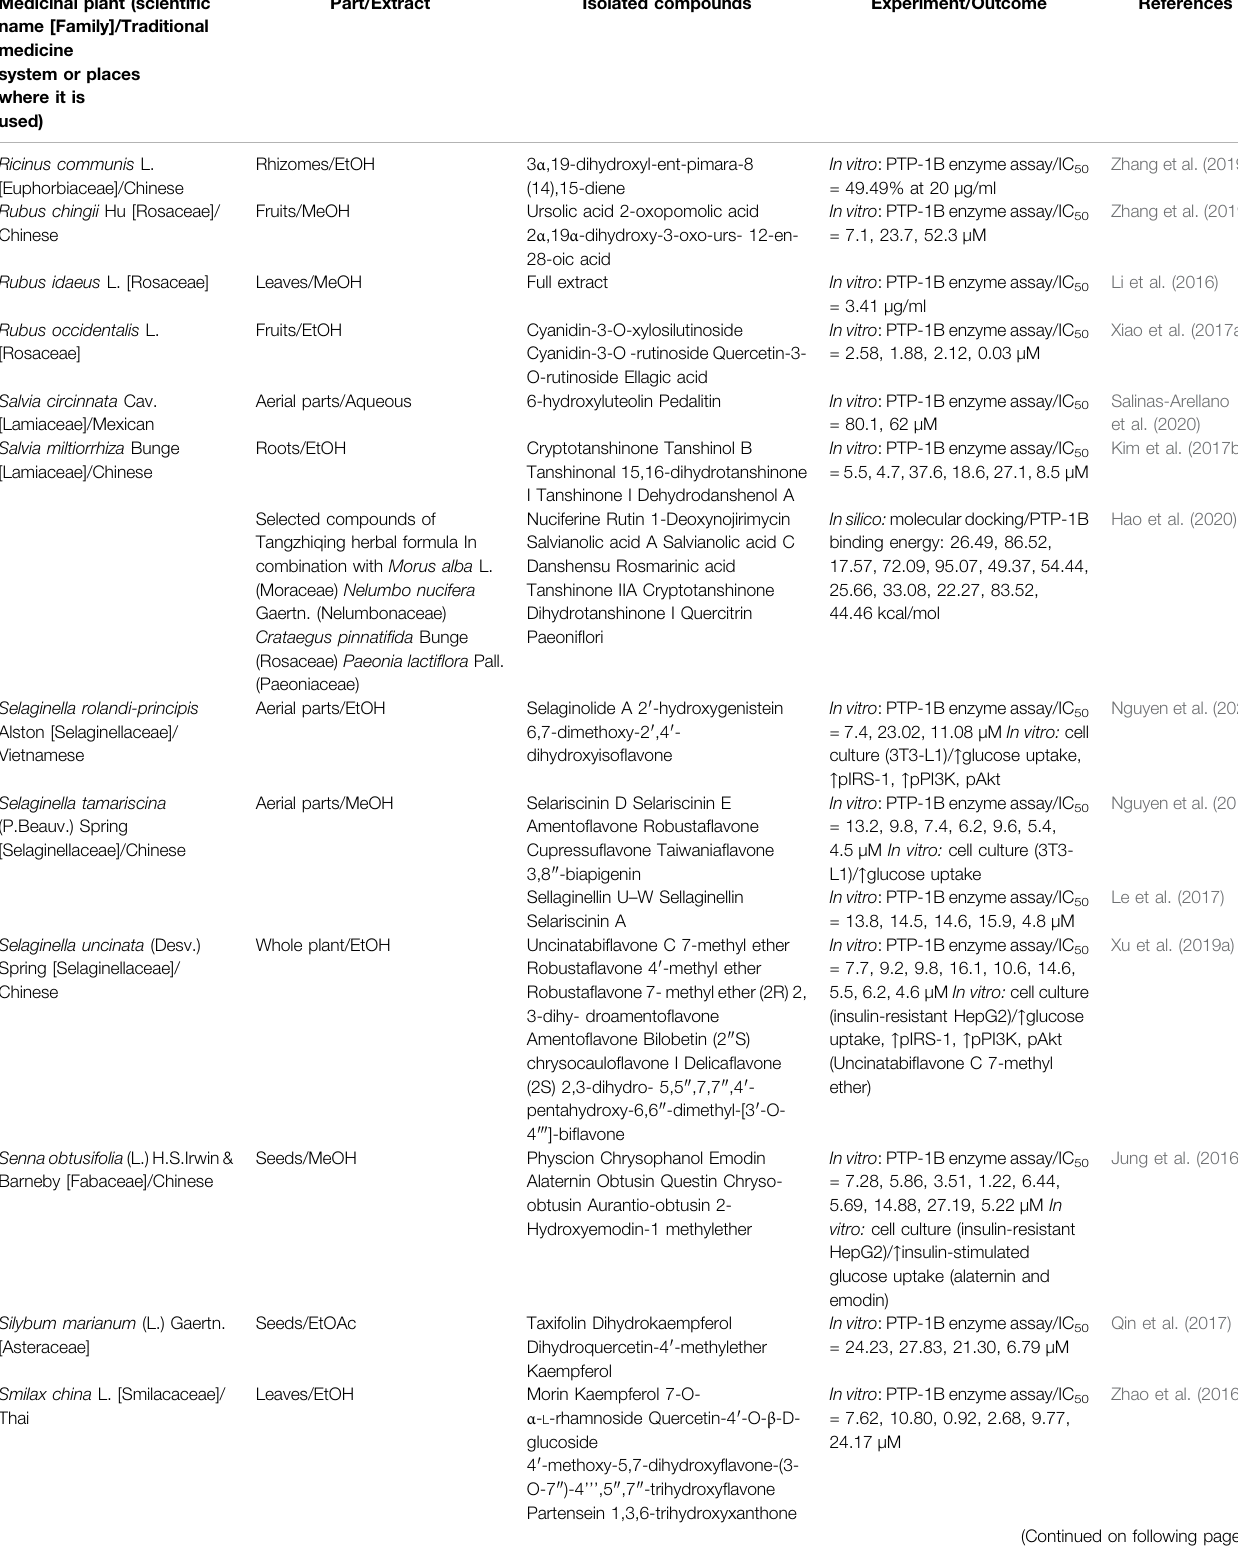
Medicinal plant (scienti fi c name